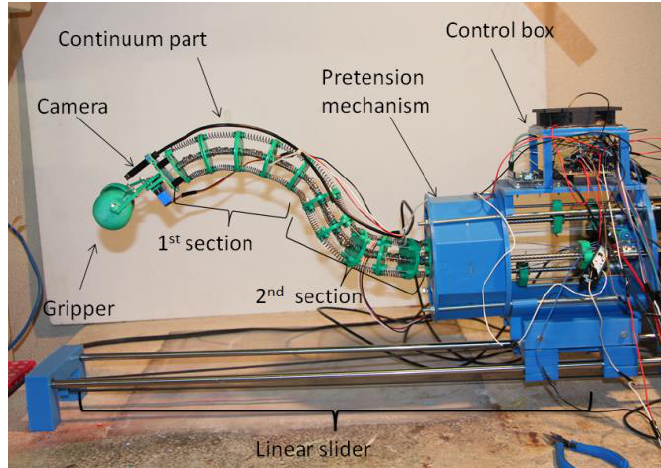
Figure 1. TakoBot design and experimental setup.